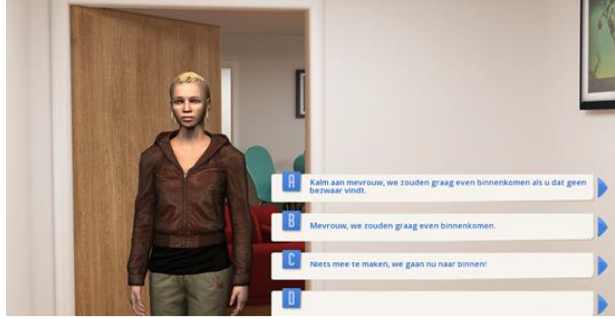
Figure 1. Example screenshot of a training